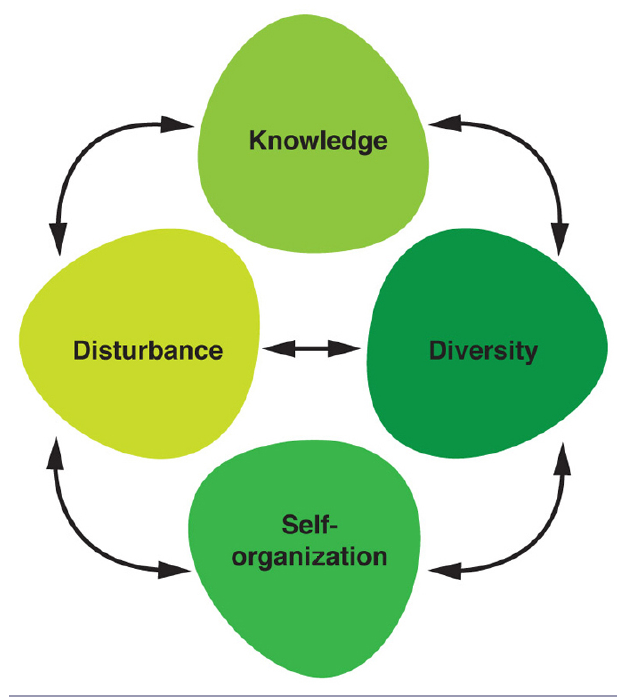
Fig. 7 . Change (disturbance), learning, diversity, and self- organization as critical attributes of resilient systems. Adopted from Folke et al. (2003) and modified by Barthel et al.